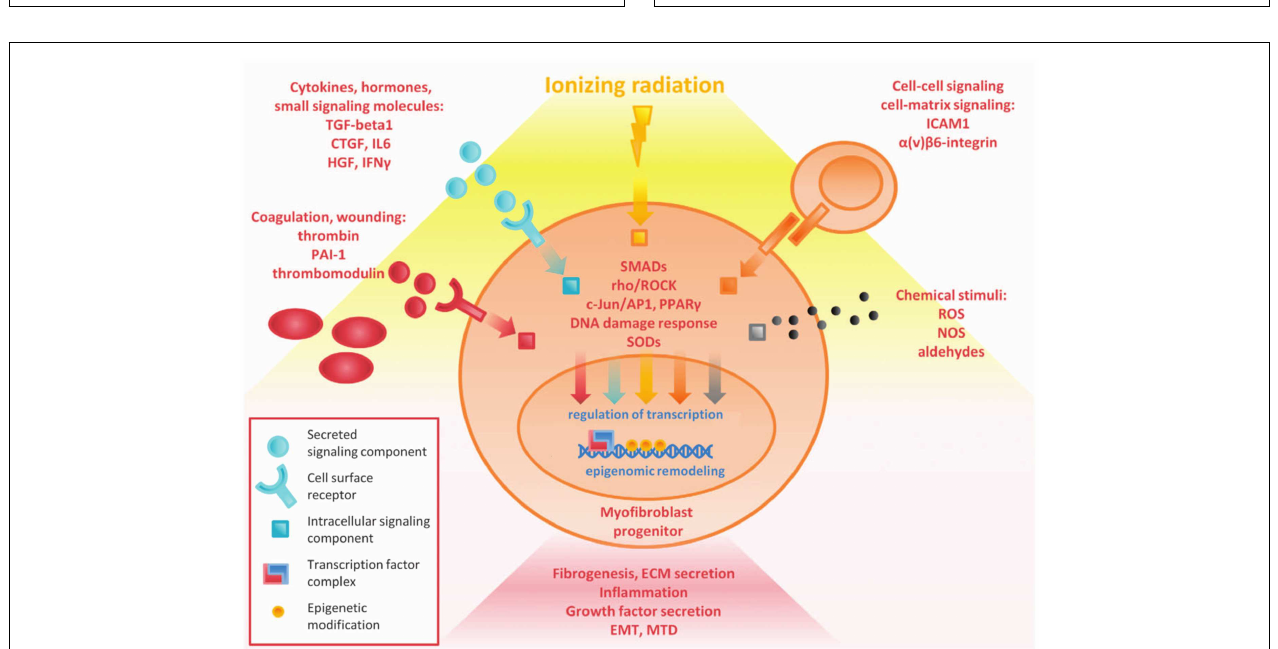
FIGURE 3 | Overview of complex pathways in tissue fibrosis